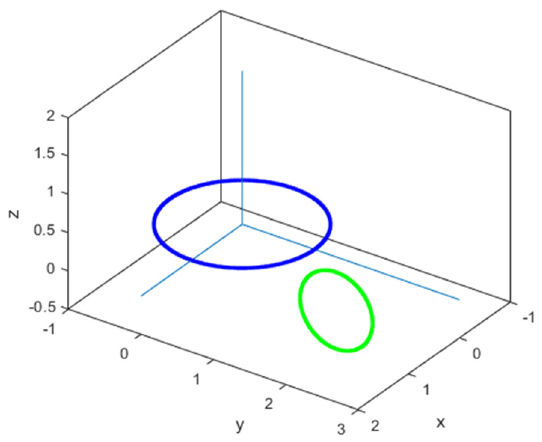
Figure 5. Case (a): two perpendicular circular loops. Not a singular case, ( a = 1, b = c = 0, L = l = 1).